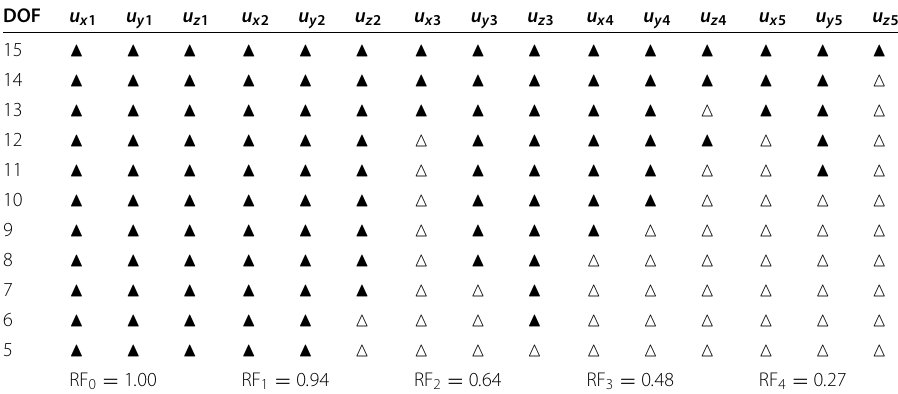
Table 2 BTD models for 0/90/0, R/a = 5 , a/h = 100